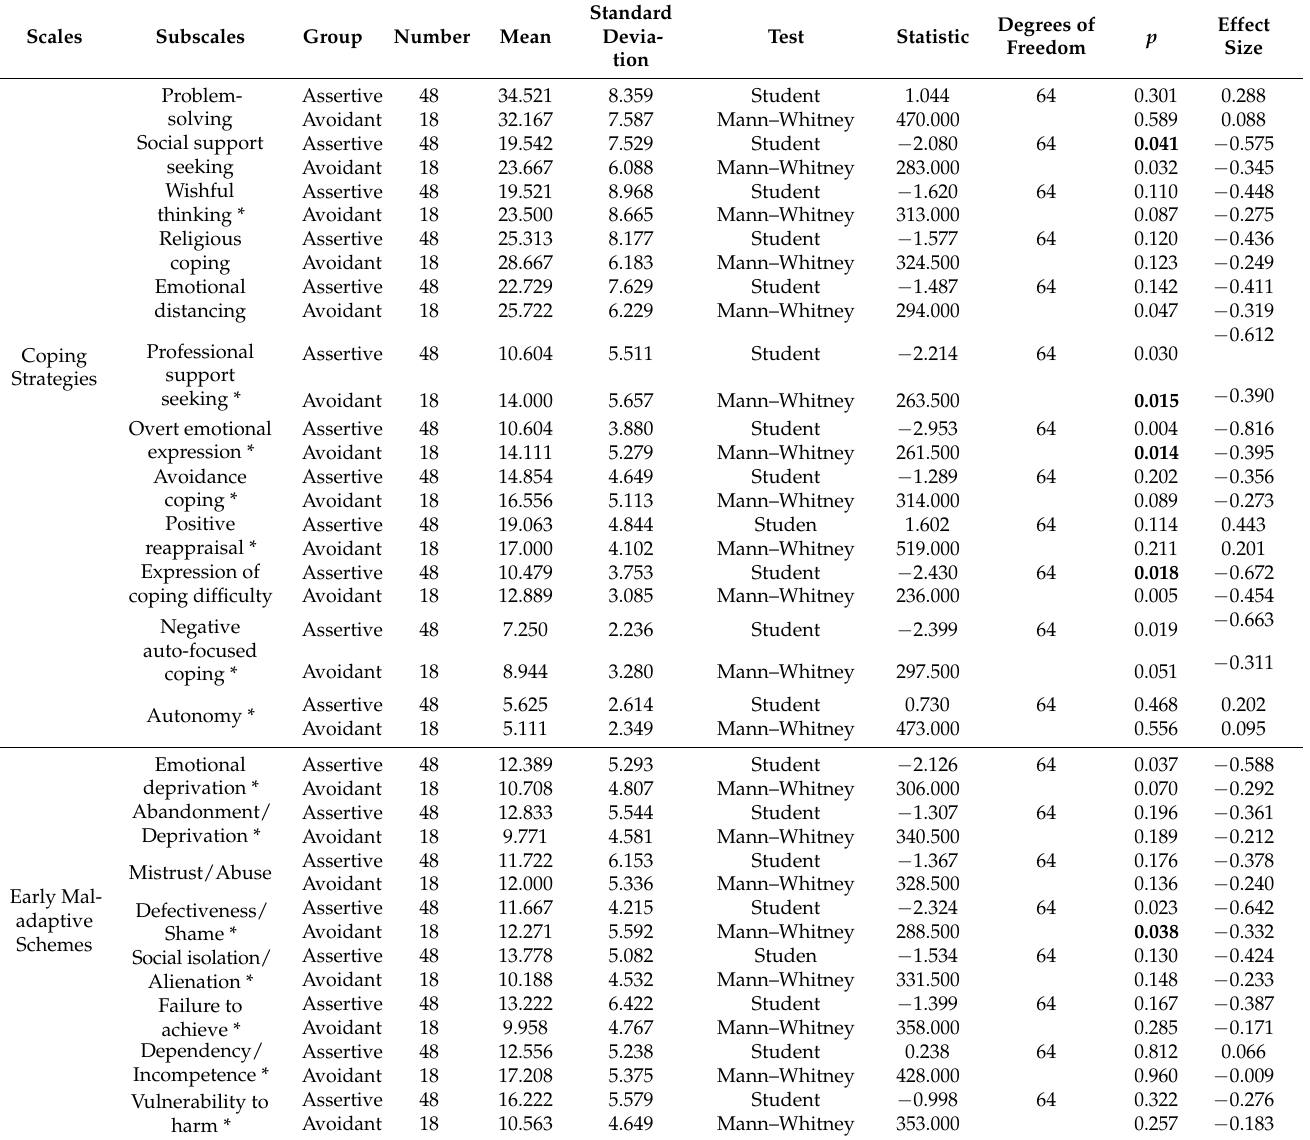
Table 3. Comparatives for coping strategies and early maladaptive schemes scores across the decisions facing body shaming. Scales